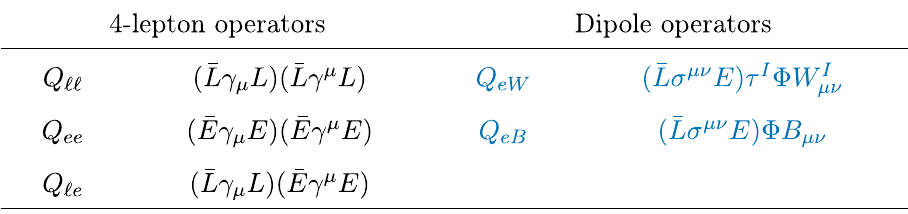
Table 2 Complete list of the dimension-6 operators (invariant under the SM gauge group) which contribute to LFV observables. Those highlighted in blue generate LFVZD at tree level. Q and L respectively denote quark and lepton SU ( 2 ) L doublets ( a , b = 1 , 2 are SU ( 2 ) L indices). U , D and E are (up and down) quark and lepton singlets. (cid:7) represents the ↔ D μ (cid:7) ≡ Higgs doublet (and (cid:7) † (cid:7) † ( D μ (cid:7)) − ( D μ (cid:7)) † (cid:7) ),